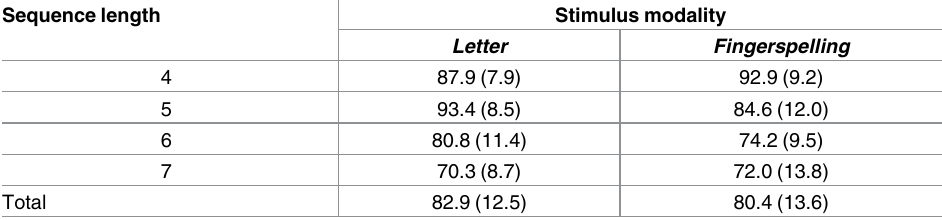
Table 1. Mean accuracy(SD) for the letter and fingerspelling conditions during fMRI.